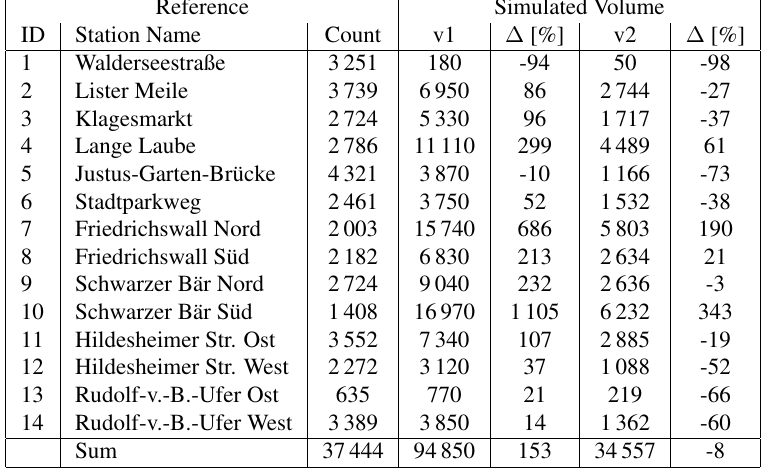
Table 1. Overview of bike counts at the reference stations and the two simulated versions with volume per day (v1 & v2) and relative error ( ∆ ) to the